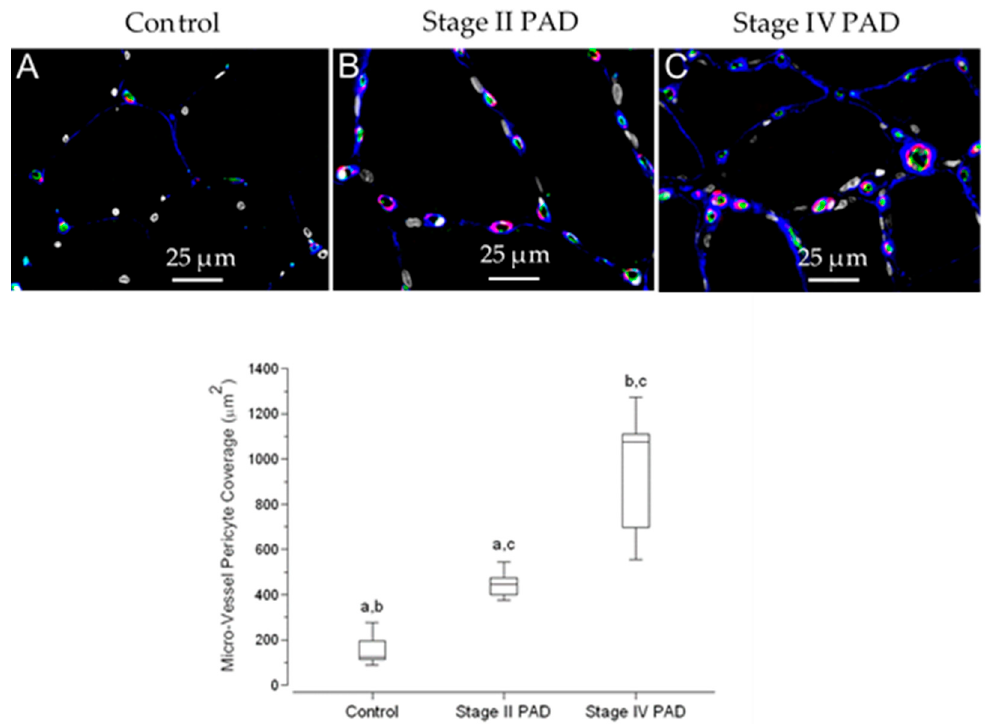
Figure 9. Micro-vessel pericyte coverage is increased in the calf muscle of patients with PAD. Slide specimens of calf muscle biopsies from control subjects ( N = 5) and patients with Stage II ( N = 5) and Stage IV ( N = 5) PAD were labeled with antibodies specific for Collagen IV ( Blue ), α Smooth Muscle Actin ( α SMA) ( Red ), endothelial cell CD-31 ( Green ) and nuclei ( Grey / White ). Fluorescence images were captured with a widefield microscope (40 × objective). Pericyte segments were identified as α SMA positive labeling intimately associated with the micro-vessel endothelium. Micro-vessels of control muscle ( A ) had few pericyte segments, and these occupied very small areas. The number and size of pericyte labeling events increased in patients with Stage II PAD ( B ) and were greater in patients with Stage IV PAD ( C ). Scale bar = 25 µ m. Pericyte coverage per microscopic field was determined by Quantitative Fluorescence Microscopy as the sum of the areas occupied by pericyte segments. We analyzed five 40× fields in duplicate slide specimens per patient and control. Coverage for controls and patients with Stage II and Stage IV disease is presented as Fence Box Plots, and differences were analyzed by the randomization test where: a—significantly different at p = 0.009; b—significantly different at p < 0.009; c—significantly different at p < 0.007.